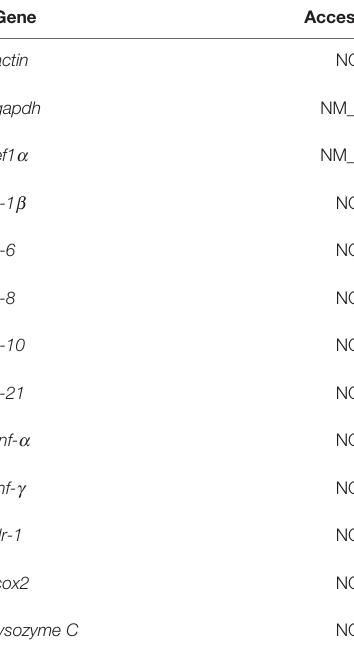
TABLE 1 | Primers used for qRT-PCR